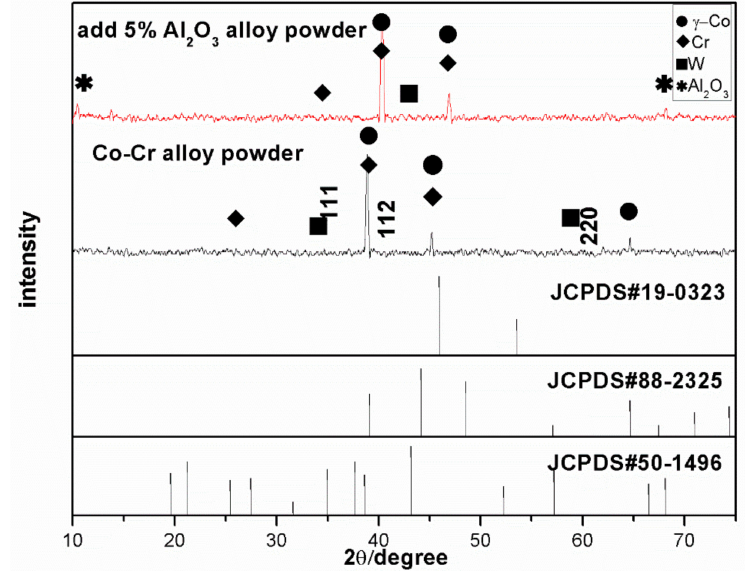
Figure 1. X-ray powder di ff raction (XRD) patterns of original and modified